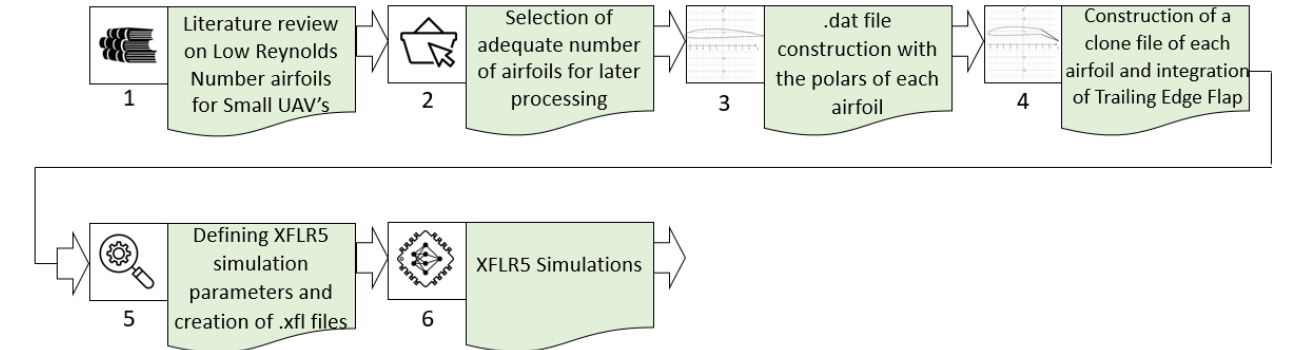
Figure 4. The steps that were taken for the airfoil data collection.